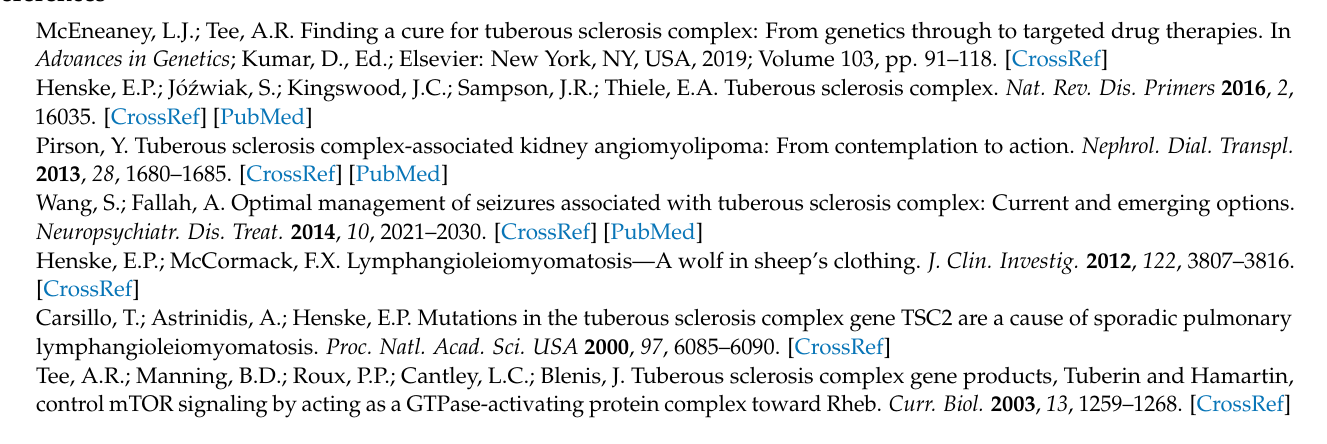
Table S1: normalized data for metabolomic data presented in Figure